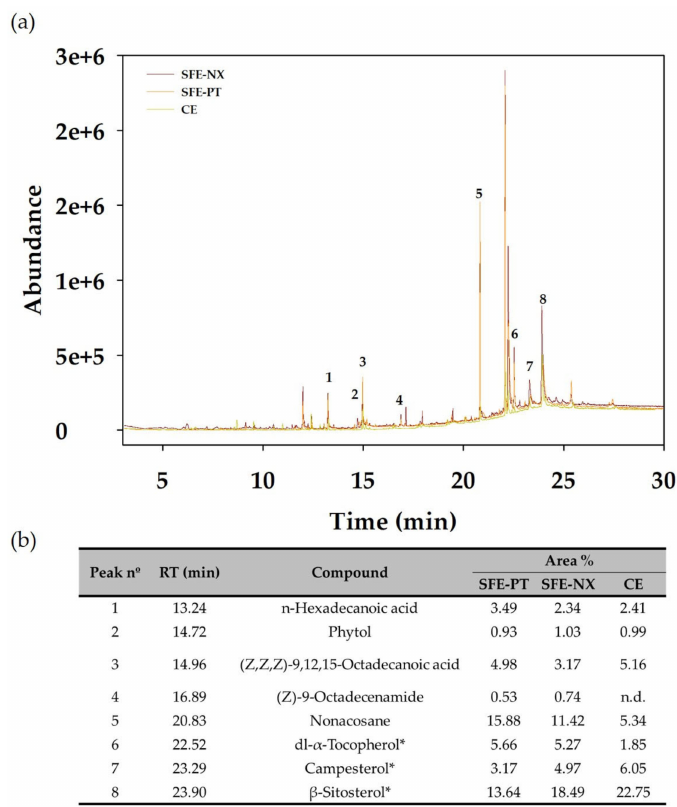
Figure 4. ( a ) Total ion chromatogram (TIC) of the optimized supercritical fluid (SFE) and conventional (CE) extracts derived from Parthenon (SFE-PT) and Naxos (SFE-NX) by-products. ( b ) Identified compounds in the extracts obtained from broccoli by-products. * denote the quantified compounds; RT: retention time; n.d.: not